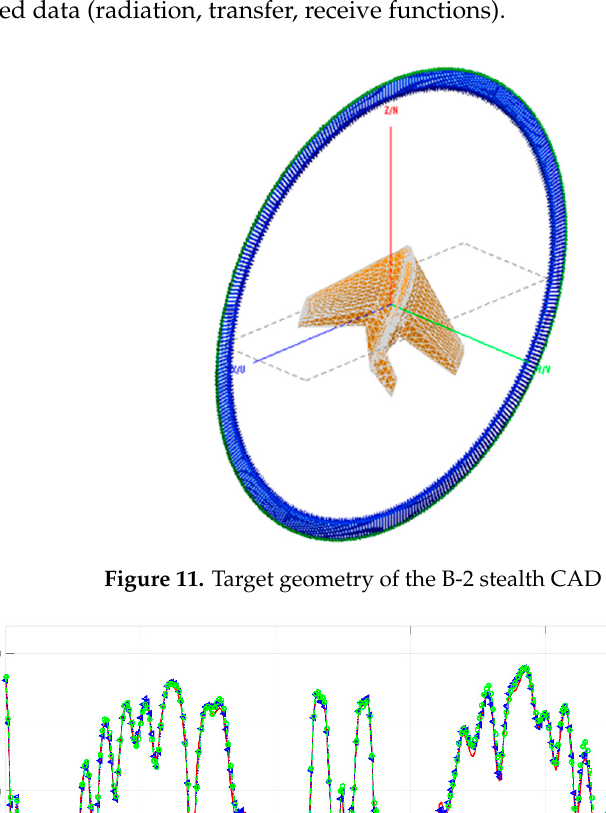
( b ) Figure 13. Realistic stealth CAD model simulation results: ( a ) the number of iterations as a function of the number of basis functions; ( b ) the computation time per iteration as a function of the number of basis functions.